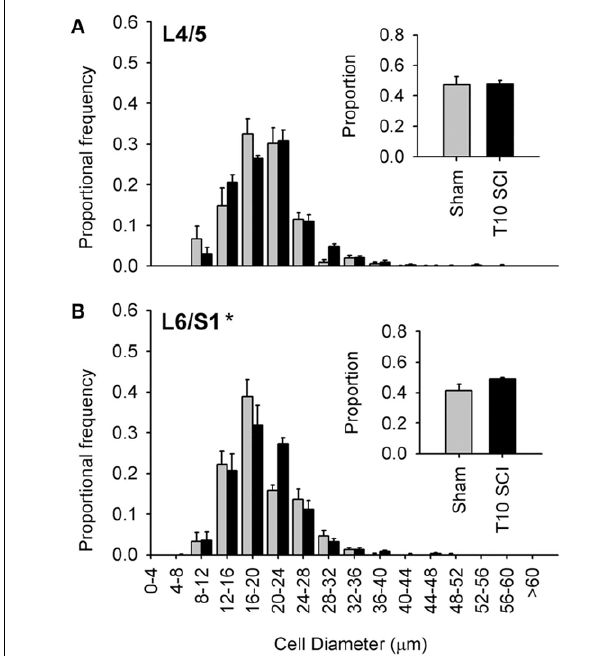
FIGURE 6 | Low-thoracic (T10) spinal cord injury elicited only modest changes in size of the most caudal capsaicin-sensitive dorsal root ganglion neurons. (A) No difference in size distributions of TRPV1-expressing DRG neurons in L4/L5 DRGs. (B) There was a small but significant rightward shift in the size-frequency distribution of L6/S1 DRG neurons ( P < 0.05, K–S goodness-of-fit test), but this was much less dramatic than that which occurred afterT3 SCI (see Figure 4 ). Ganglia were harvested 1month after sham (gray) or completeT3 SCI